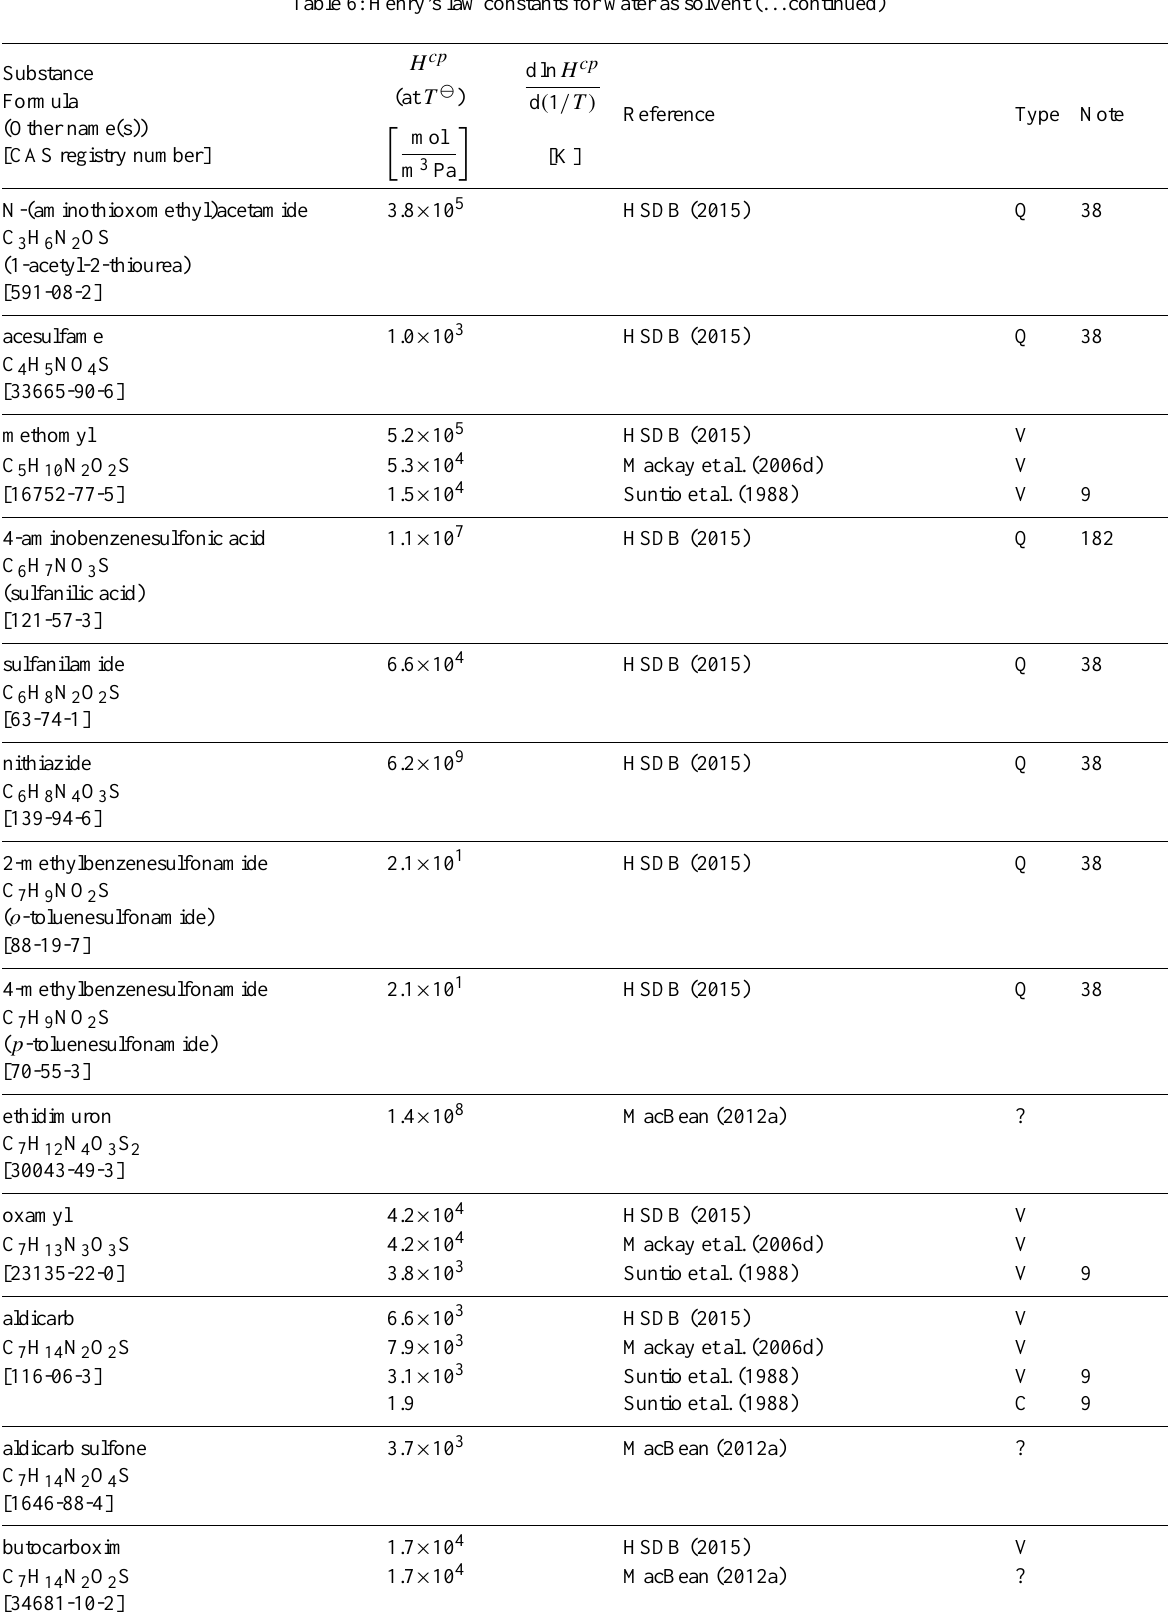
Table 6: Henry’s law constants for water as solvent